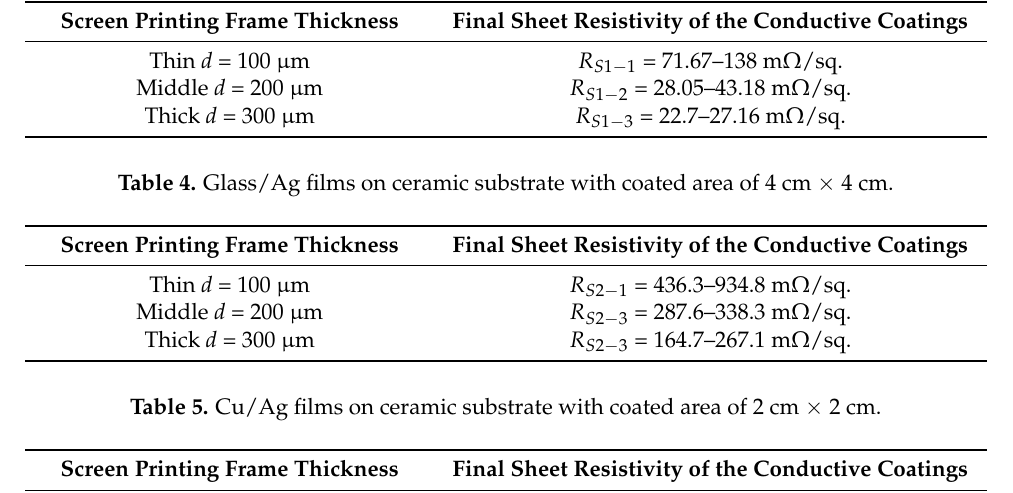
Table 3. Cu/Ag films on ceramic substrate with coated area of 4 cm × 4 cm.